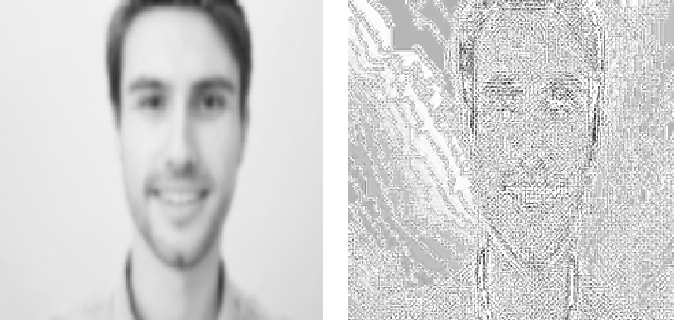
Figure 16. Result of deblurring on a comprehensive image set (Image 02_IM): ( Left ) input image; and ( Right ) output of the ICA neural